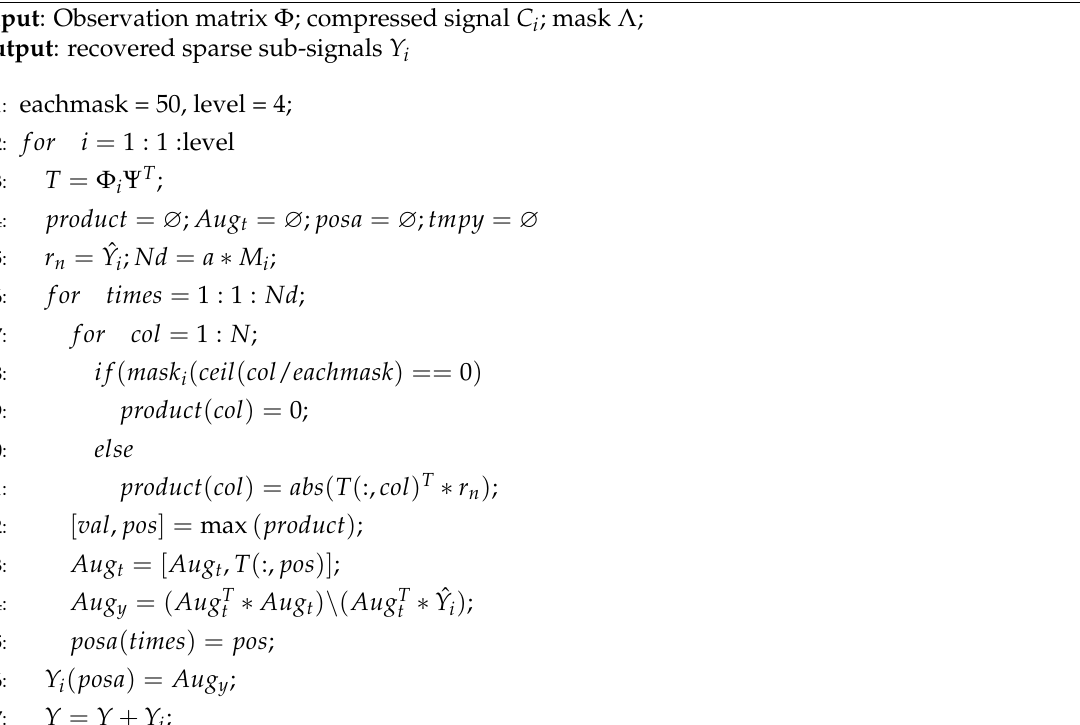
Algorithm 2 OMP algorithm based on a mask and observation